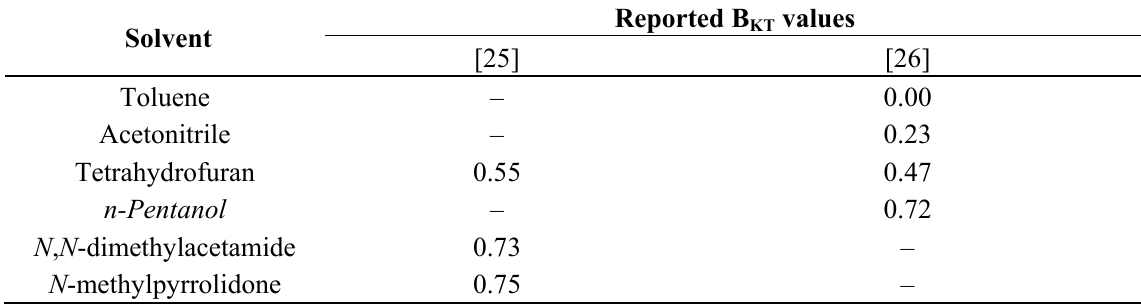
Table 3. Basicity characteristics of solvents according